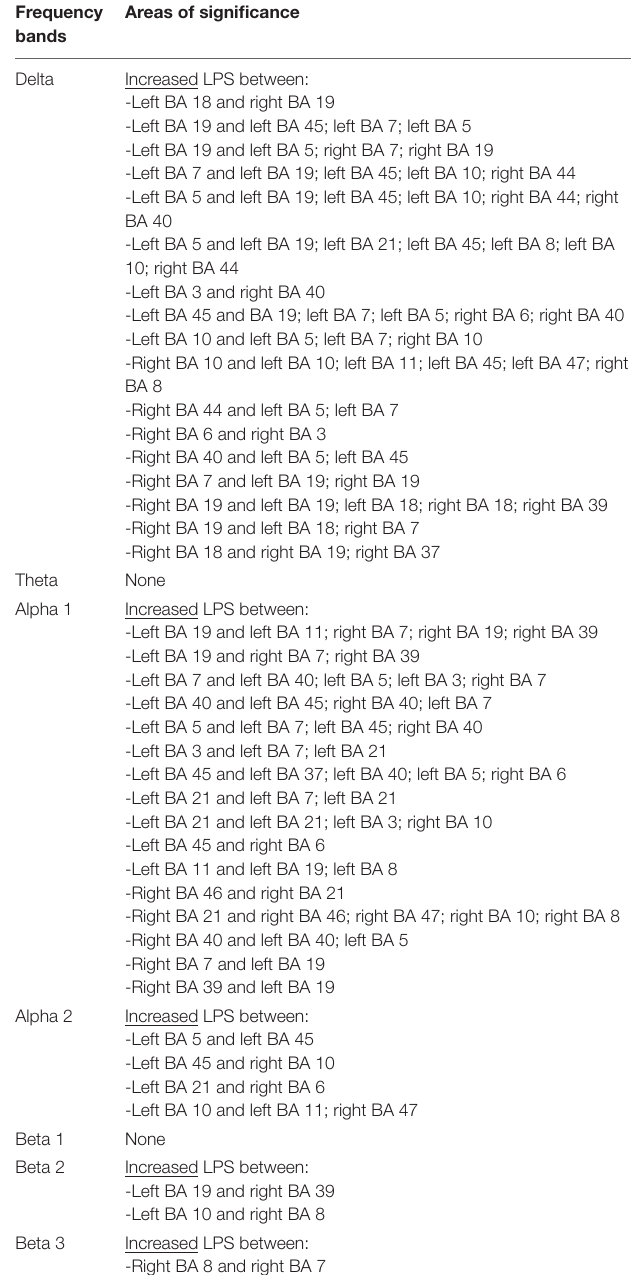
TABLE 3 | Changes in “lagged phase synchronization” in mHD subjects compared to C subjects in all frequency bands and the involved BAs. Frequency Areas of bands